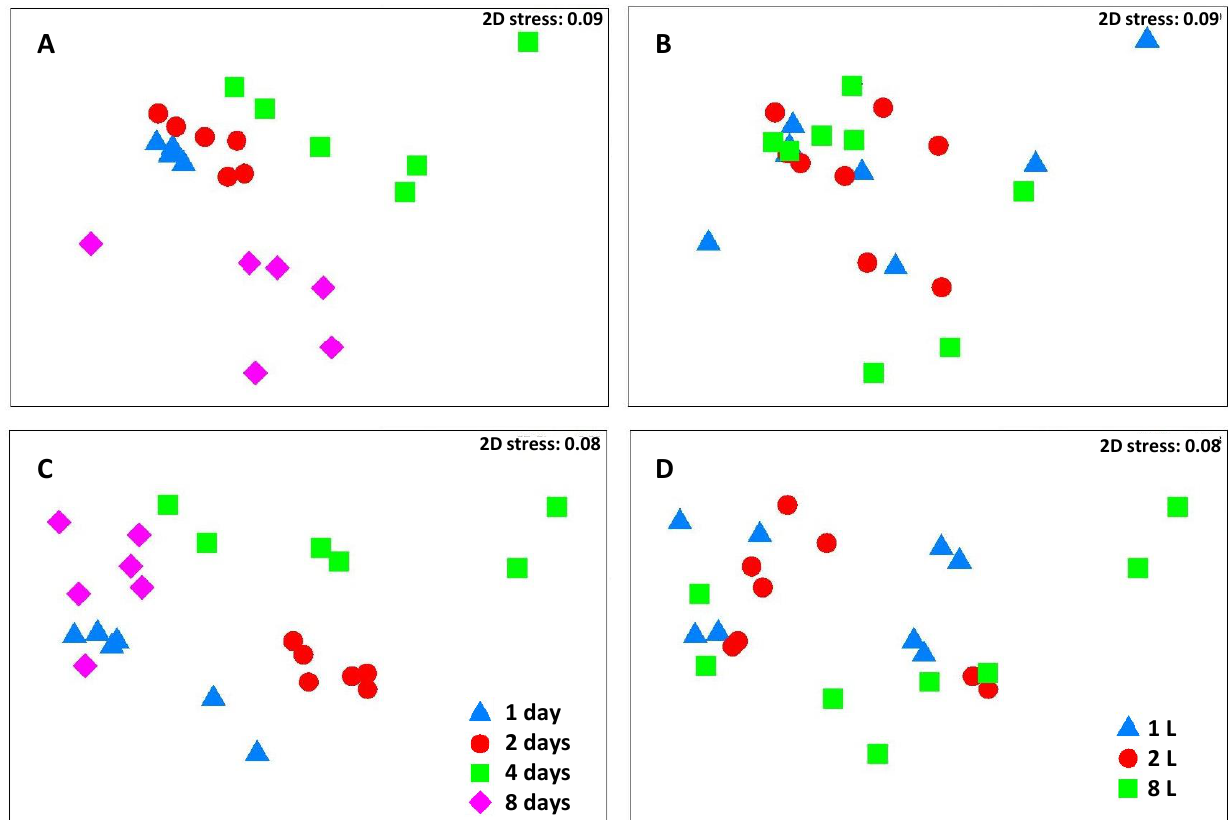
Figure 4. Non-metric multidimensional scaling (nMDS) plot of phytoplankton community structure across experimental durations in the ( A ) autumn and ( C ) summer experiments, and experimental volumes in the ( B ) autumn and ( D ) summer experiments. nMDS plots are based on Bray – Curtis similarities and non-transformed abundance data.